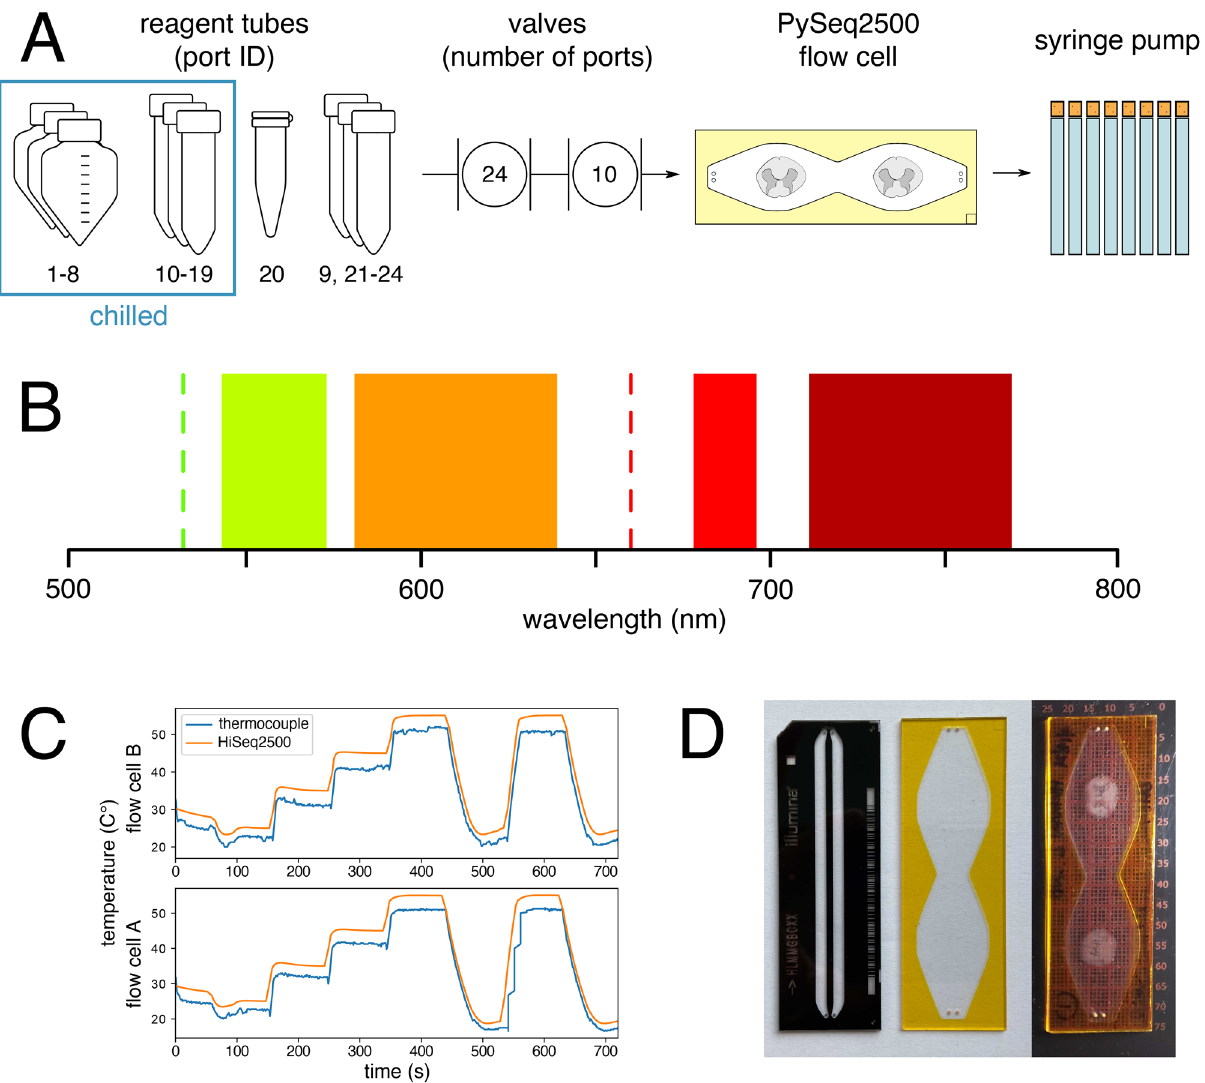
Figure 1. PySeq2500 control of HiSeq 2500 components. ( A ) The fluidic path is duplicated and independently operated for each A and B flow cell. Reagents are drawn from their respective tubes into each flow cell by an 8 × 250 µL barrel syringe pump. Reagents are selected using a 24 port rotary valve with only 19 ports fully plumbed on a stock HiSeq 2500. With minor modifications, reagent lines can be added to ports 9 and 21–24. Up to 18 reagents per flow cell can be stored on the onboard chiller. A 2 hole stage inlet or 8 hole stage inlet is selected with the 10 port rotary valve. ( B ) Fluorescent markers are excited with lasers at 532 nm and 660 nm and emitted light is detected simultaneously at 558–32 nm, 610–60 nm, 687–20 nm, and 740–60 nm with bandpass filters. ( C ) A and B flow cell stage temperatures can be independently heated and cooled to various setpoints (orange) as measured using an external thermocouple (blue). ( D ) From left to right, an Illumina HiSeq 2500 2 lane flow cell, an empty PySeq2500 flow cell, and human spinal cord sections enclosed in a PySeq2500 flow cell atop a slide ruler used to measure ROIs to be